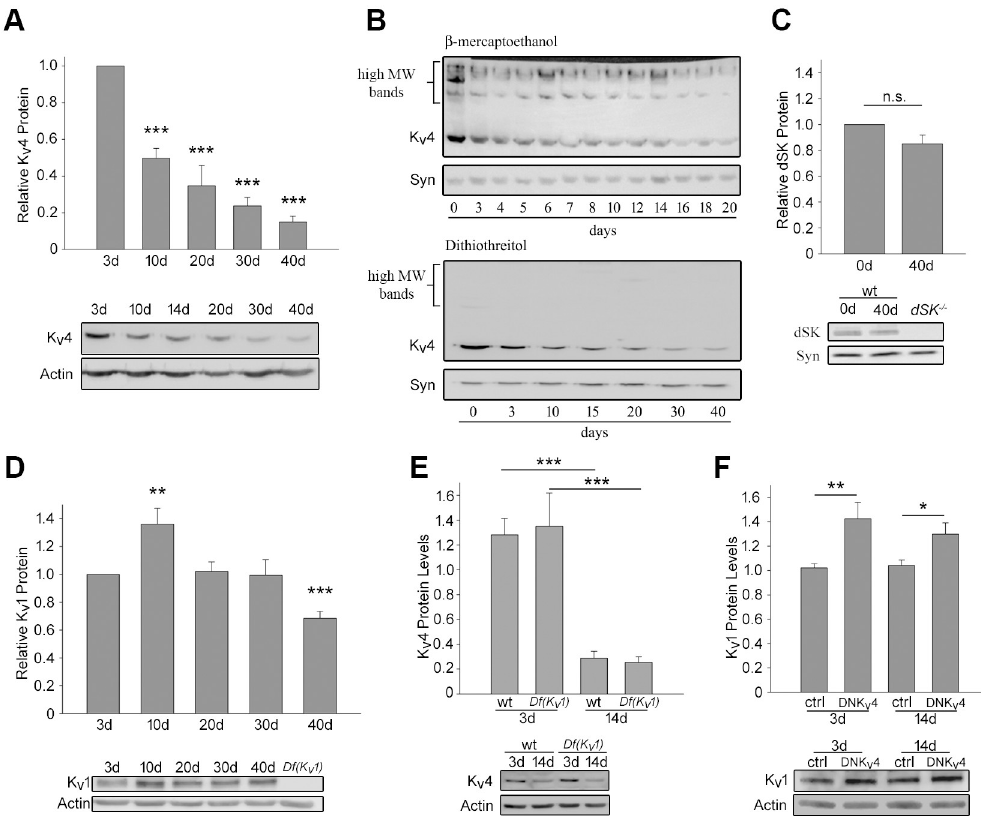
Fig 1. K v 4/Shal protein levels decline with age, independent of K v 1/Shaker. Representative immunoblots and quantitative analyses for K v 4/Shal, dSK, and K v 1/Shaker, relative to Actin or Syntaxin (Syn) loading controls, as indicated. (A) Representative immunoblots and quantitative analyses (N = 7) of relative K v 4/Shal levels from wild-type fly heads at indicated days after eclosion. (B) Representative immunoblots of K v 4/Shal levels from fly head homogenates in sample buffers containing either β -mercaptoethanol ( top ) or the stronger reducing agent, DTT ( bottom ). (C) Relative levels of dSK protein in wild-type heads from newly-eclosed ( < 24 hours; 0d) and 40 day old flies (N = 10); dSK -/- null mutant flies were used to verify the anti-dSK antibody. (D) Relative levels of K v 1/Shaker protein assayed from fly heads of wild-type flies aged as indicated (N = 11); Df(K flies were used to verify the anti-K v 1 antibody. (E) K v 4/Shal protein levels assayed from wild-type (wt) and v 1) Df(K v 1) fly heads at 3 and 14 days AE, as indicated (N = 12). (F) K v 1/Shaker protein levels assayed from elav- GAL4 >> UAS-DNK v 4 (DNK v 4) and the UAS-DNK v 4 background control (ctrl) fly heads at 3 and 14 days, as indicated (N = 18). For all immunoblots, 5 fly heads per sample, N indicates the number of samples assayed. Shown are mean values +/- SEM; � p < 0.05, �� p � 0.01, ��� p � 0.001, Student’s